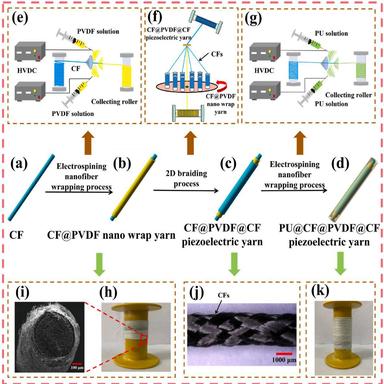
The preparation process and morphology of piezoelectric yarn. (a–d) Schematic diagram of the yarn structure corresponding to each stage. (e and g) Schematic illustration of the electrospinning equipment. (f) Schematic illustration of 2D braiding process. (h) The digital electronic image of CPY. (i) The high magnification SEM images of CPY. (j) Appearance and morphology of the obtained CPCY. (k) Piezoelectric yarn of physical map.